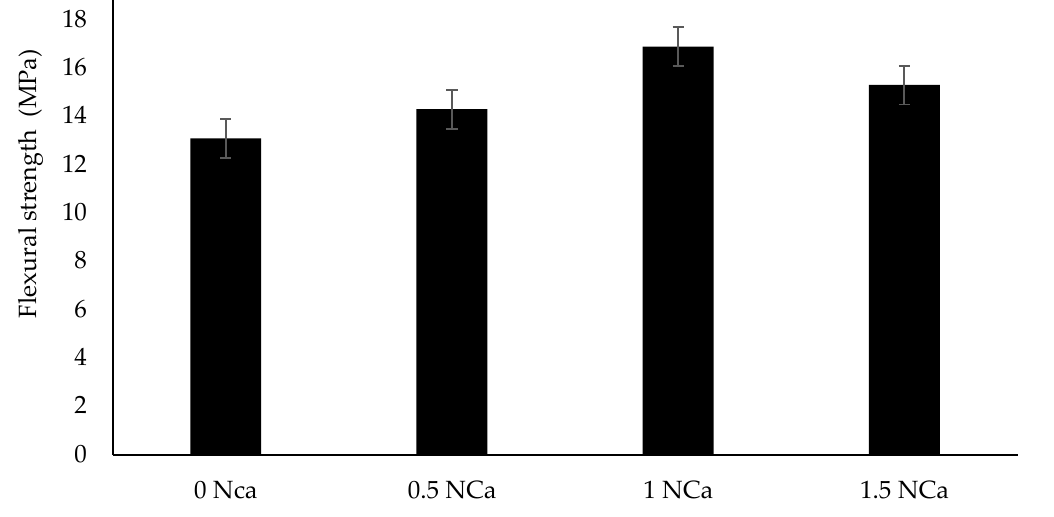
Figure 10. Flexural strength results of NCa-ECC. Table 4. Strain, mid-span displacement, flexural toughness, and ductility results.